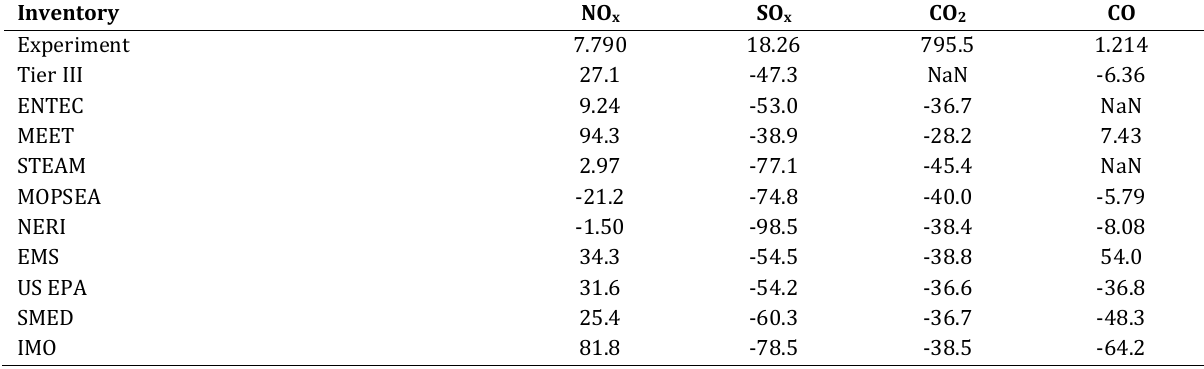
Table 5: Inventory deviations from the experimentally measured total emission amounts in % for the auxiliary engines at berth. The experimental measurements are given in the second row in kg per time equal to the experiment duration according to the third column of Table